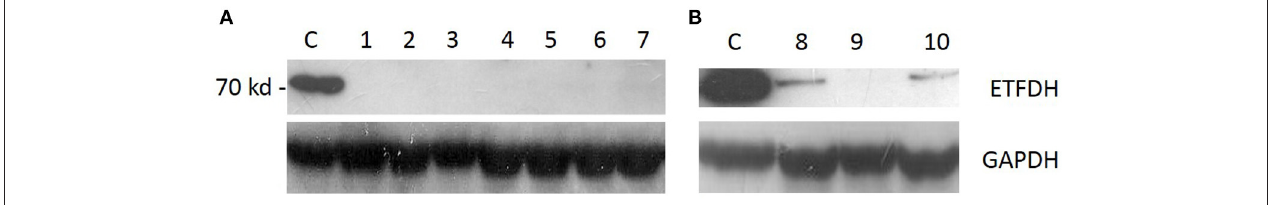
FIGURE 2 | Western blot analysis: ETFDH protein expression was absent in patients with two variants [ (A) , pts 1–7] and severely reduced in patients who harbored a single heterozygous variant [ (B) , pts 8–10].